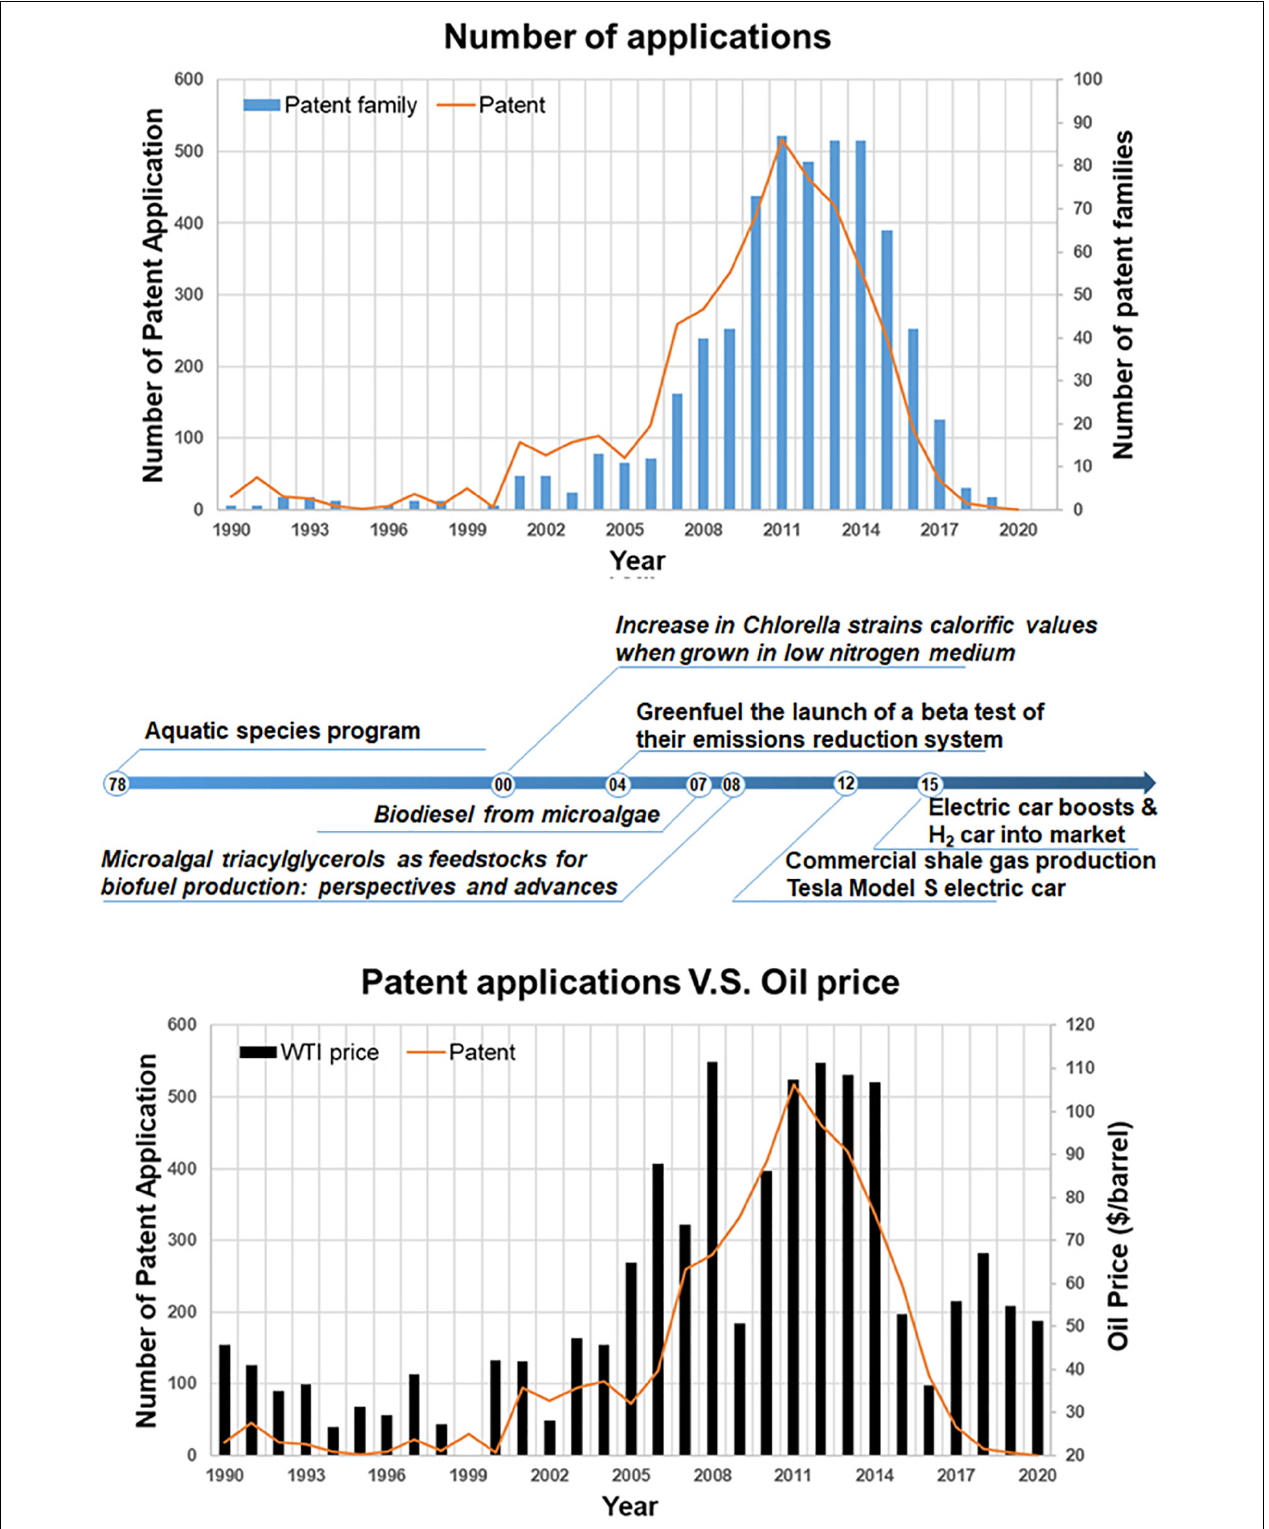
FIGURE 1 | The patent application changes in last 30 years. The upper figure is the application in terms of single patent and patent family. The bottom figure is the application changes with the crude oil prices. The timeline in the middle marks some milestones for microalgae biofuel R&D development.